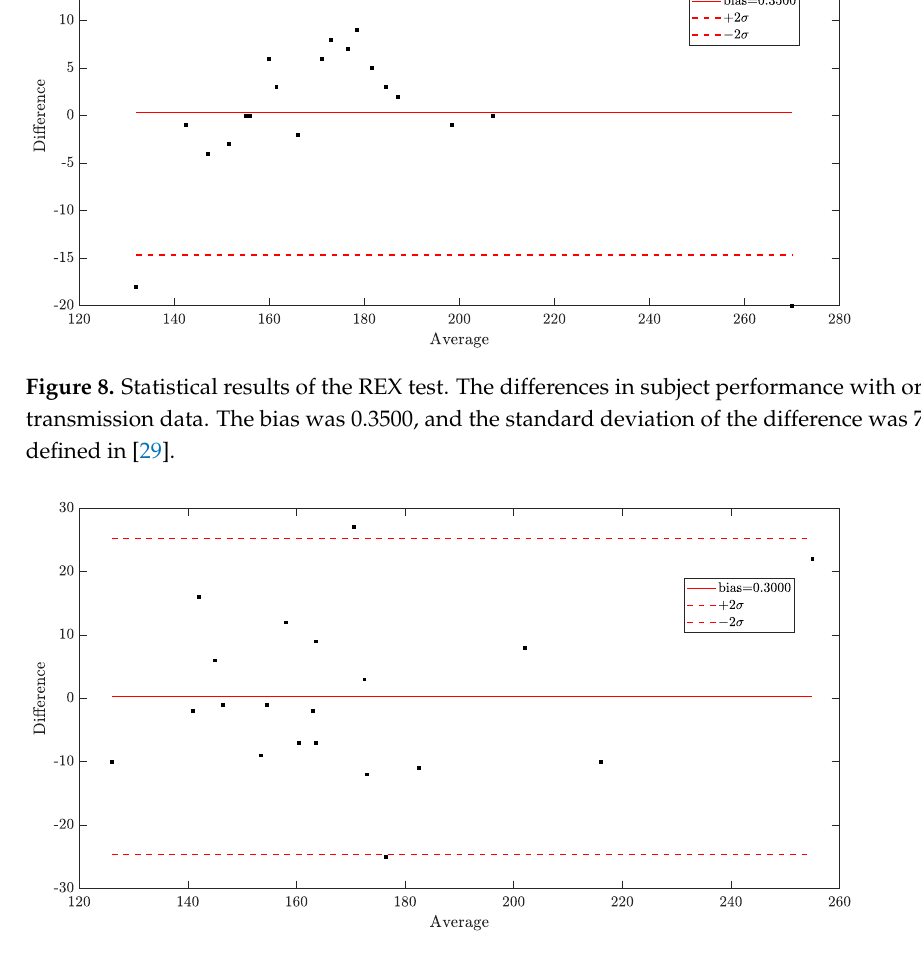
Figure 9. Statistical results of the Radner test. The differences in subject performance with or without transmission data. The bias was equal to 0.3000, and standard deviation of the difference was 12.7325, as defined in